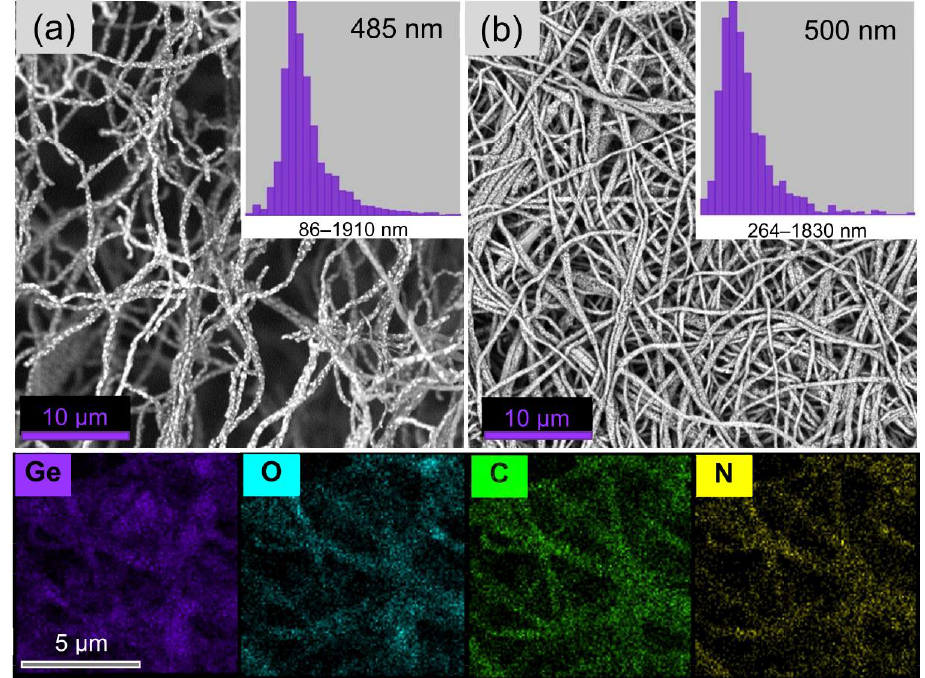
Figure 9. SEM images of self-standing paper-like electrospun fibrous membranes prepared ( a ) without and ( b ) with post-spinning cold pressing. An open and loose structure is obtained in the former case, whereas in the latter, the membrane has a more compact and tight structure and is rigid. Bottom: elemental mapping of the Ge, O, C and N fiber components (readapted from ref. [57] with permission. Copyright 2017, Elsevier).